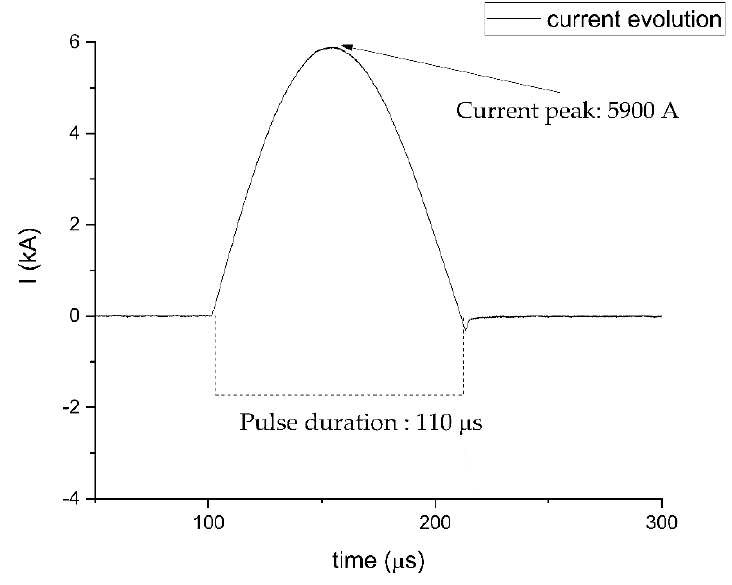
Figure 1. Waveform and duration of the typical electrical current pulse delivered by the power